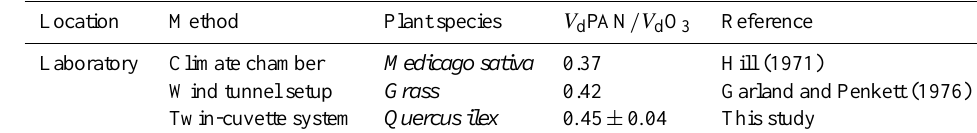
Table 5. Comparison of the deposition velocity ratio of O 3 and PAN in previous studies.